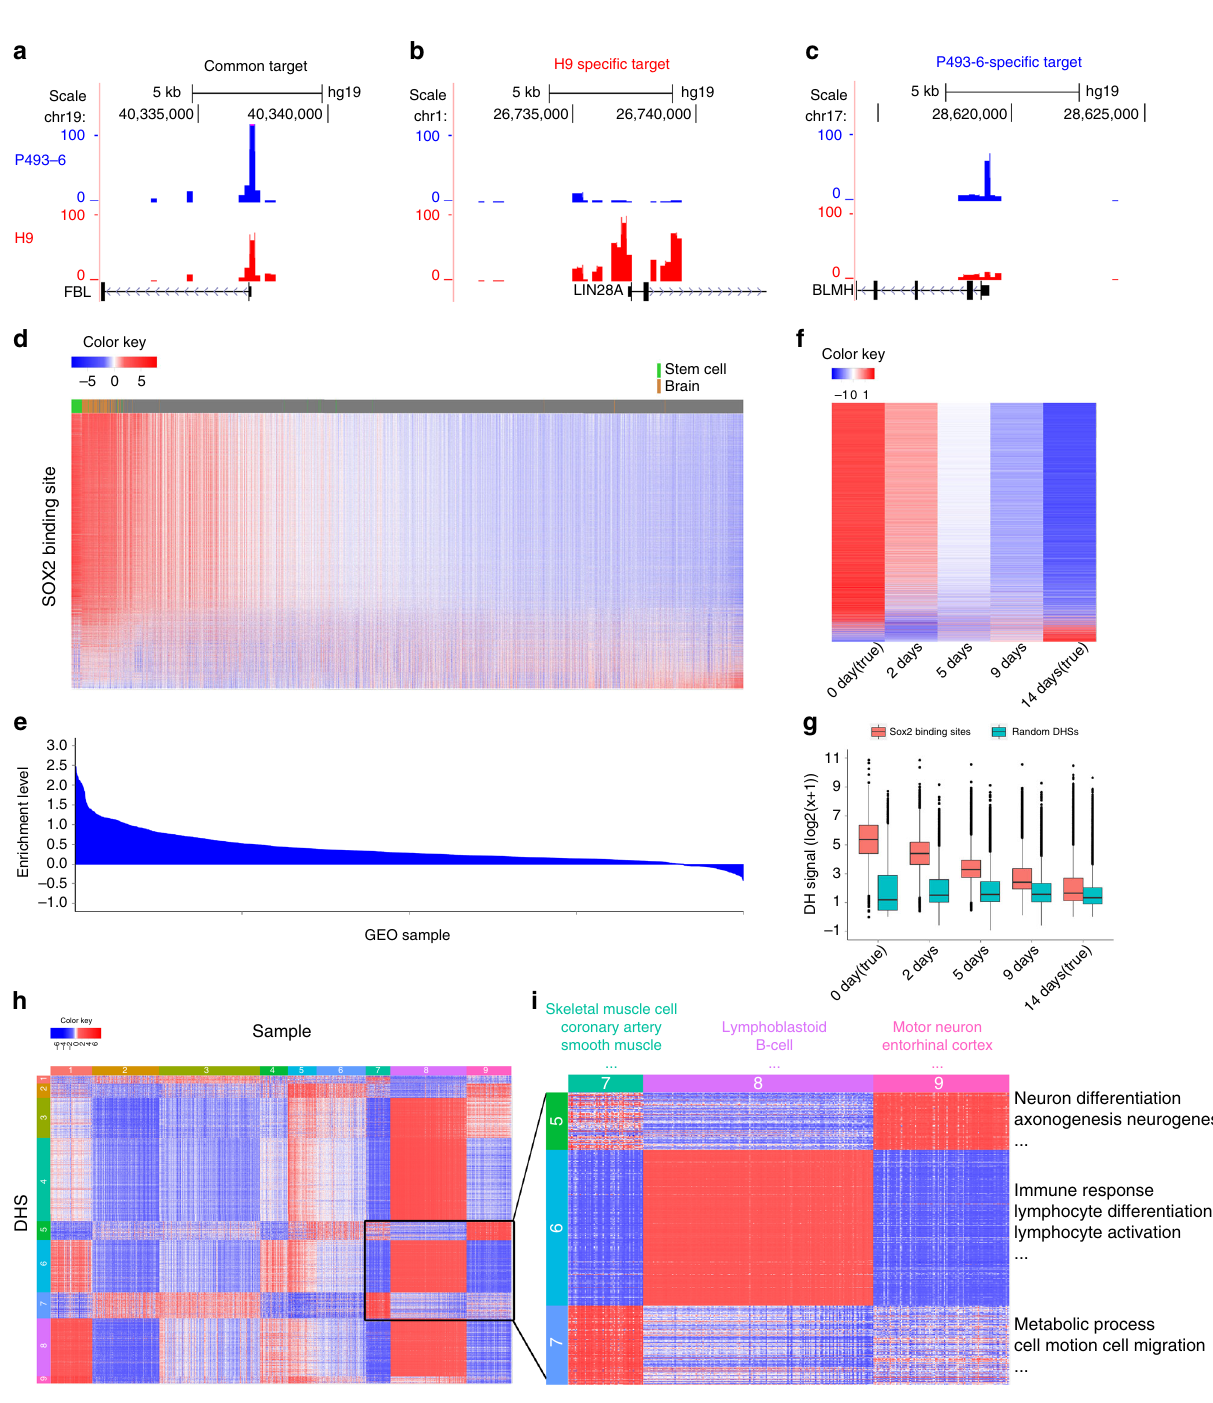
Fig. 6 Predicting regulome using PDDB. a – c Predicted DH in promoter regions of FBL ( a ), LIN28A ( b ), and BLMH ( c ) in P493-6 B cell lymphoma and H9 embryonic stem cells. For H9, PDDB contains multiple replicate samples, which produced similar results. One replicate is shown here and the other replicates are shown in Supplementary Fig. 31. d Predicted DH at 6931 SOX2 binding sites in 2000 PDDB samples. Each column is a sample, and each row is a binding site. Values within each row are standardized to have zero mean and unit SD before visualization. e Relative DH enrichment level when comparing SOX2 binding sites with random sites (Supplementary Methods). f Predicted DH at SOX2 binding sites in H7 stem cells after 2, 5, and 9 days of differentiation. True DH from undifferentiated H7 cells and cells at differentiating day 14 in the training data are also shown. Rows are SOX2 sites and columns are time points. Values within each row are standardized before visualization. g Predicted DH at SOX2 binding sites are compared with predicted DH at 10,000 random DHSs. At each time point, DH values from all sites are displayed using a boxplot, which shows the median (central line), interquartile range (IQR, the 1st (Q1) to 3rd (Q3) quartiles, box), and 1.5 × IQR from the Q1 and Q3 (lower and upper whiskers), respectively. h Predicted DH at 2011 MEF2A binding sites in 1061 MEF2A -expressing PDDB samples (Supplementary Methods). Each column is a sample. Each row is a MEF2A binding site. Values within each row are standardized before visualization. Samples and DHSs were clustered. i The highlighted region in h that shows DHS-clusters with increased DH in muscle, lymphoblastoid, and brain-related samples,